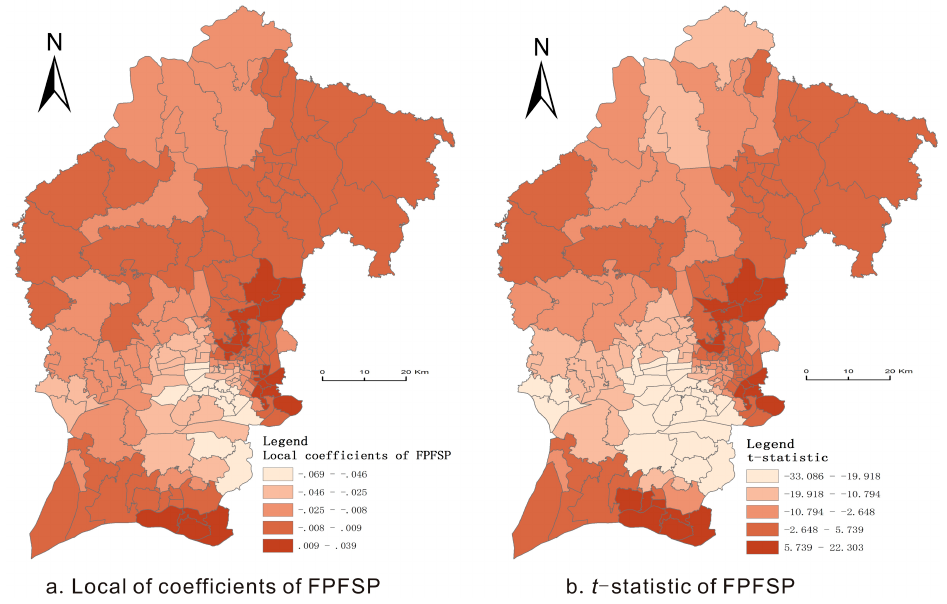
Figure 7. Distribution for local regression coefficients and t -statistics of FPFSP.